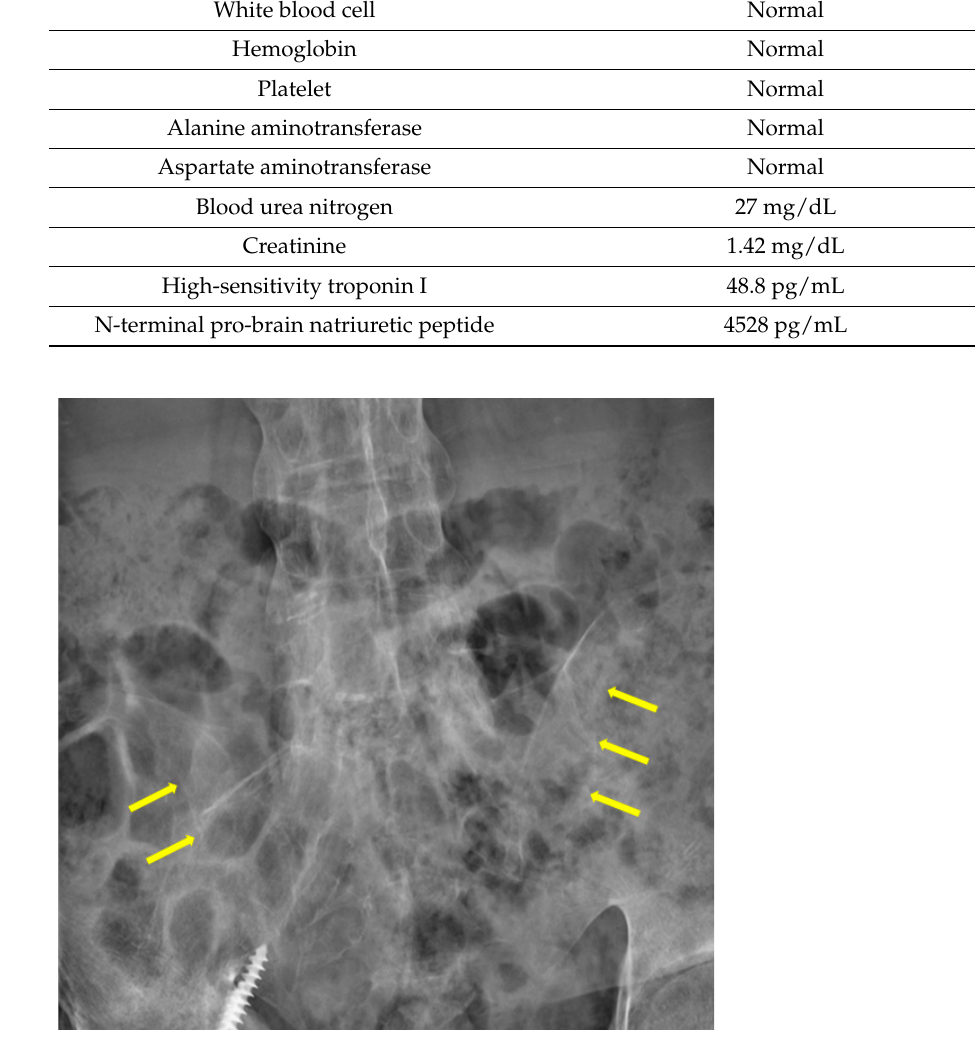
Figure 1. A plain radiograph of the pelvis demonstrated sclerosis, partial ankylosis and narrowing (yellowish arrows) over the sacroiliac joints, suggesting grade-3 bilateral sacroiliitis.